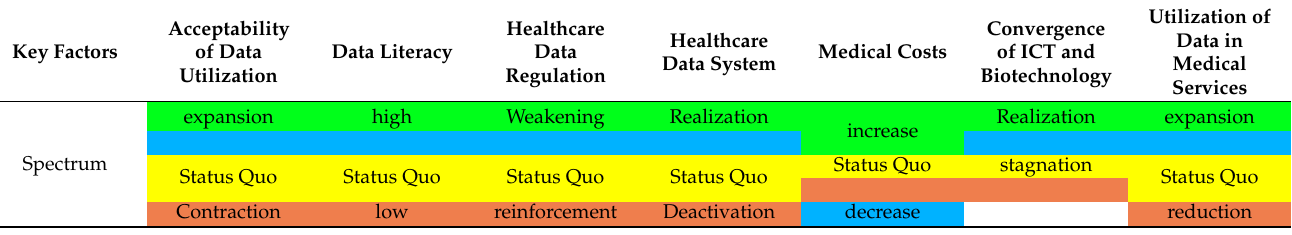
Table 5. Result of GMA scenario (expert evaluation